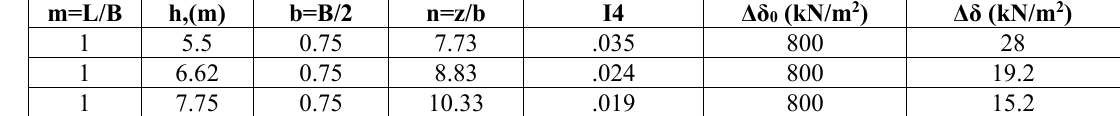
Data for calculation of additional stress due to structure by taking three dimensional effect into account. m=L/B h,(m) b=B/2